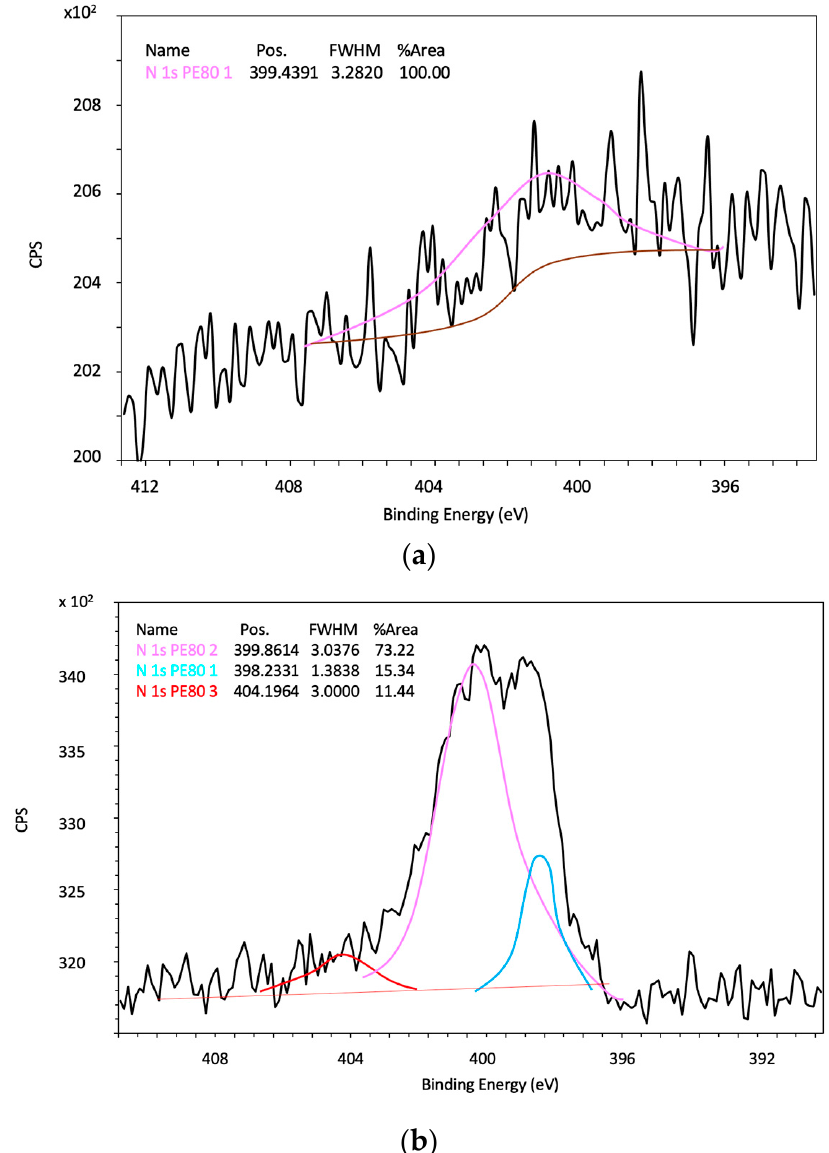
Figure 10. Narrow scan XPS spectra of N 1s of different synthesized photocatalysts and supports: ( a ) N 1 /TiO 2 /CNT, ( b ) N 10 /rGO.